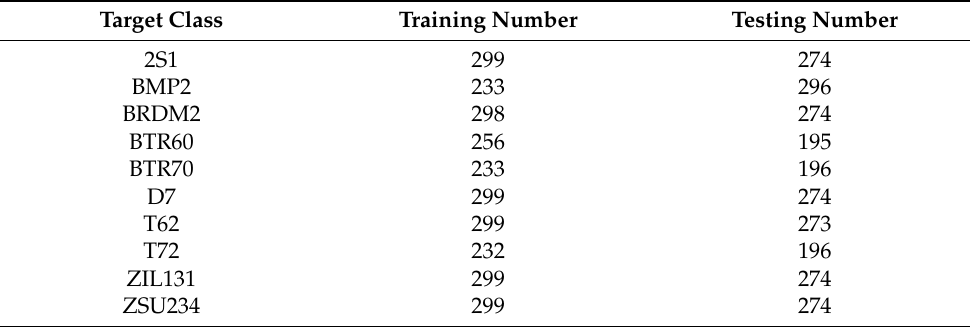
Table 1. Details of MSTAR, including target class and data